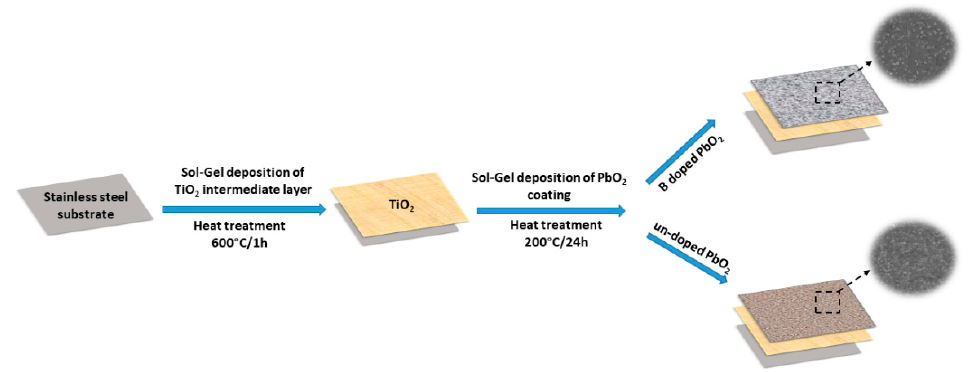
Figure 1. Preparation process of undoped and B doped SS/TiO 2 /PbO 2 anode.